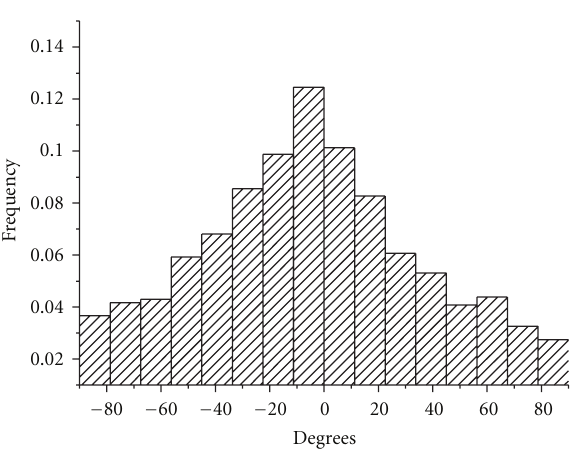
Figure 1: Fiber orientation distribution of PLA composite (PLA/sisal 30%).